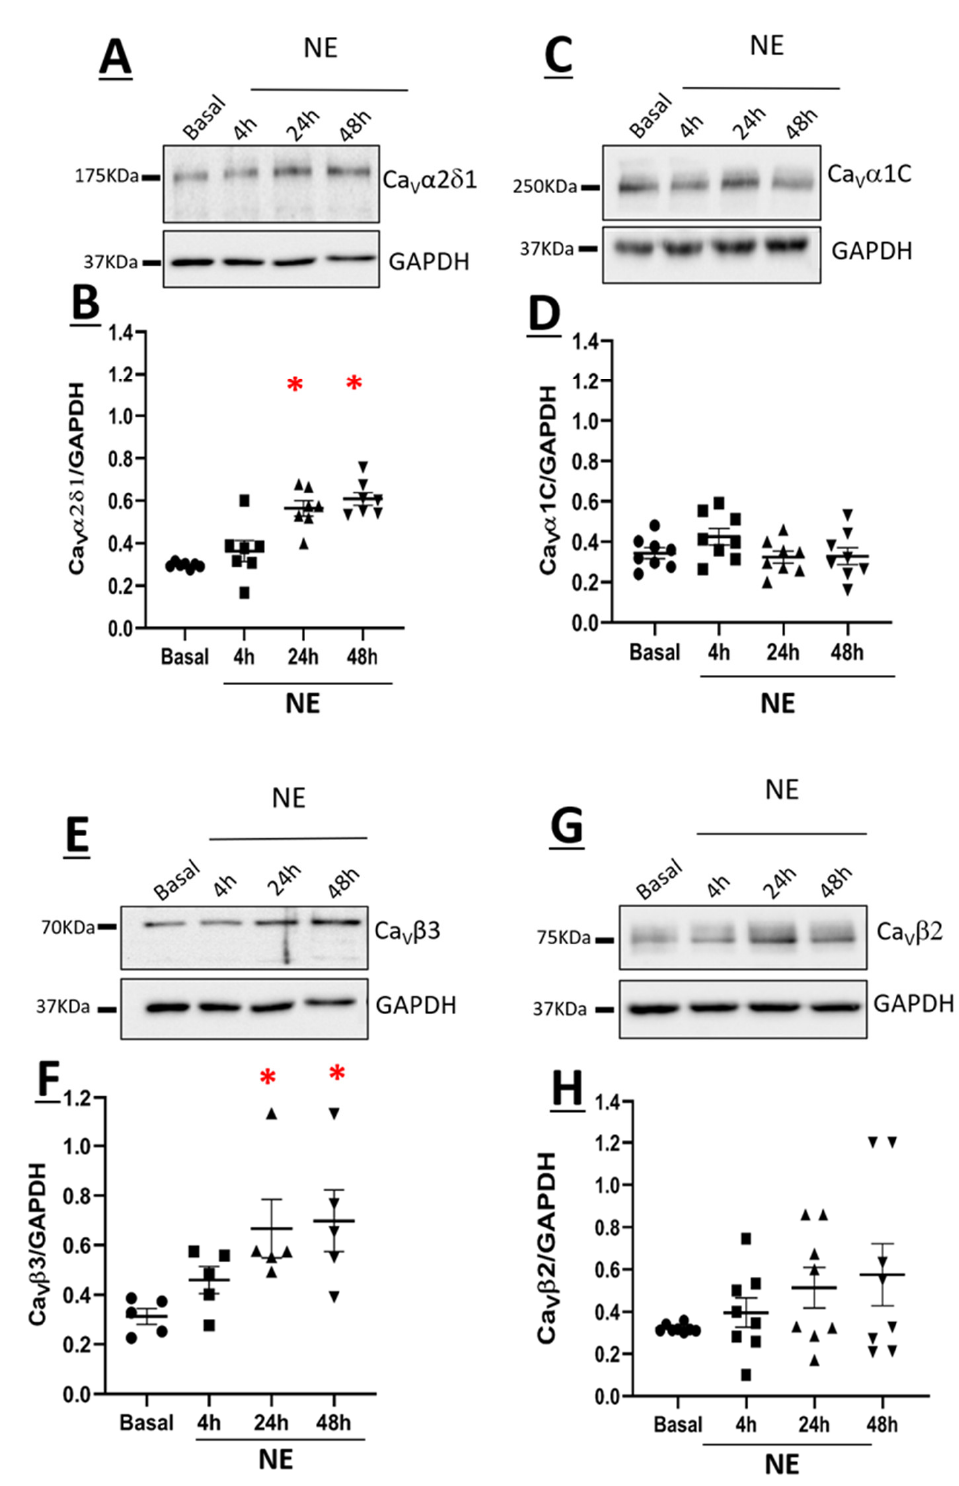
Figure 3. Expression of Ca V α 2 δ 1 ( A ), Ca V α 1C ( C ), Ca V β 3 ( E ), and Ca V β 2 ( G ) in neonatal rat cardiomyocytes. Total proteins were extracted from neonatal rat ventricular cardiomyocytes. Proteins were separated on an 8% SDS-polyacrylamide gel, transferred to a nitrocellulose membrane, and probed with anti-Ca V α 2 δ 1, anti-Ca V α 1C, anti-Ca V β 3, anti-Ca V β 2, and anti-GAPDH antibodies overnight and then incubated with HRP-conjugated goat anti-rabbit secondary antibody. Lanes were loaded with 30 µ g of proteins. NE: cardiomyocytes treated with 1 µ M norepinephrine. Graph showing the total protein expression of Ca V α 2 δ 1 ( B ), Ca V α 1C ( D ), Ca V β 3 ( F ), and Ca V β 2 ( H ) normalized to GAPDH. * p < 0.01 vs. Basal. Statistical analysis was performed using one-way ANOVA.